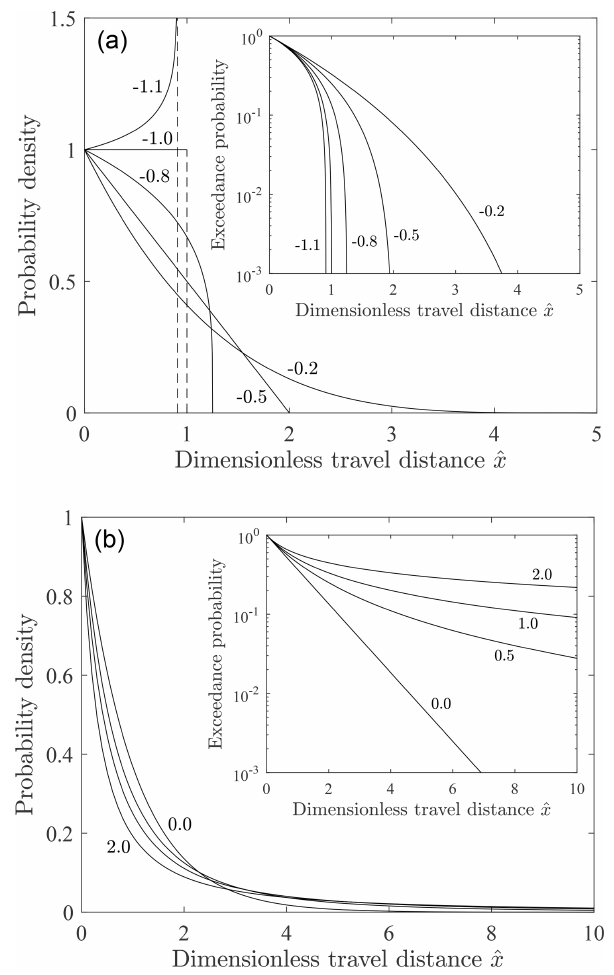
Figure 2. Plot of dimensionless probability density f ˆ x ( ˆ x ) versus dimensionless travel distance ˆ x for scale parameter b = 1 and dif- ferent values of the shape parameter a for (a) a < 0 and (b) a ≥ 0 with associated exceedance probability plots (insets). Figure repro- duced from companion paper (Furbish et al., 2021a). Compare with Fig. 1 in Hosking and Wallis